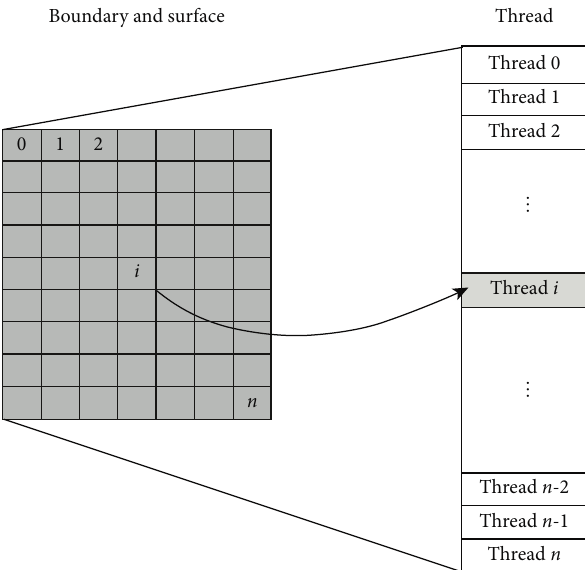
Figure 1: The boundary condition calculation thread mapping process.